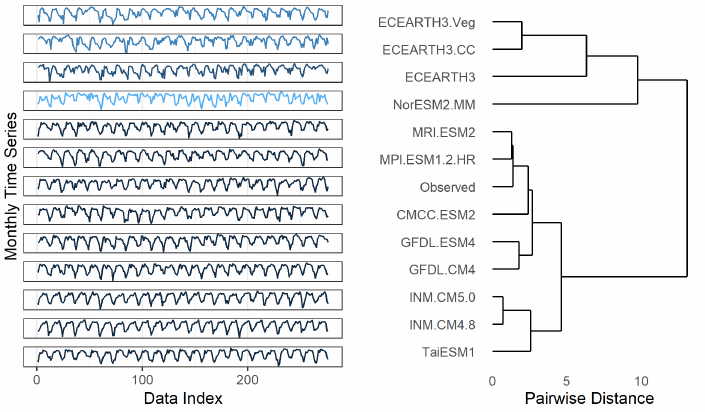
Figure 5. Clusters for the monthly minimum temperature series for the observed and climate model series (the left figure shows the cluster separation with the blue color contrast, and the right figure shows the clustering of climate models and observed data in terms of the time series similarity based on the seasonal